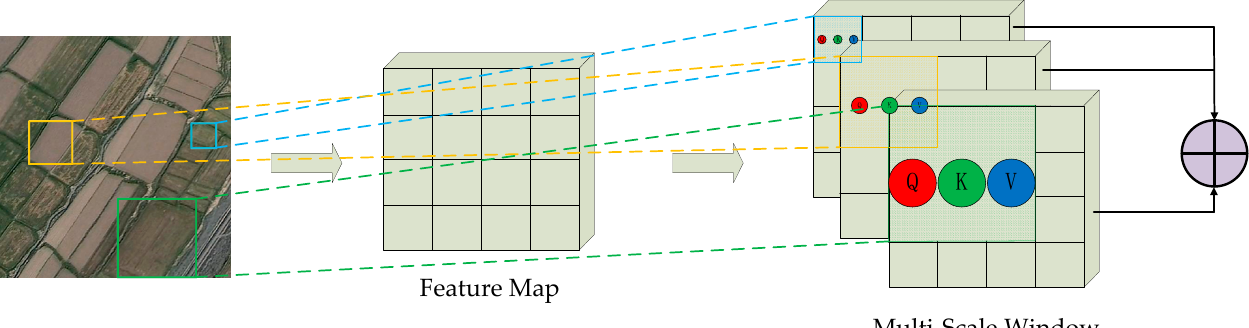
Figure 5. Schematic of multi-scale window based multi-head self-attention (MW-MSA) module. The windows of different sizes are designed to extract fields with different scales. Q. K and V are operation elements of self-attention. The design of the SMW-MSA module is the same.